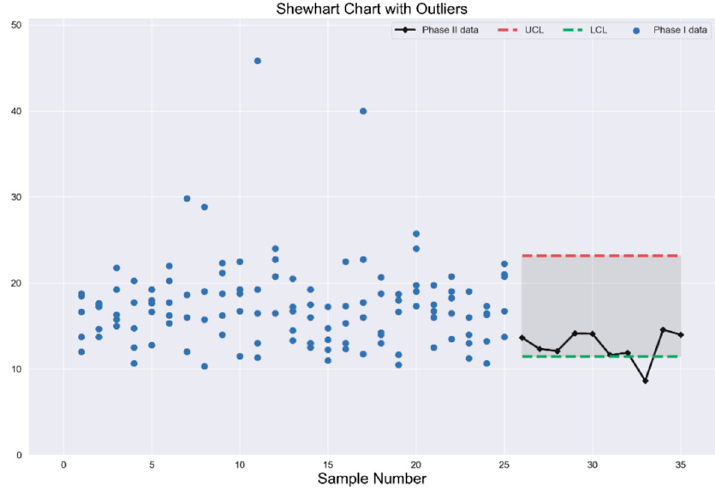
Figure 9. Scatter plot of phase-I sample and the resulting Shewhart chart with estimated parameters and 5% of outliers with magnitude 3.